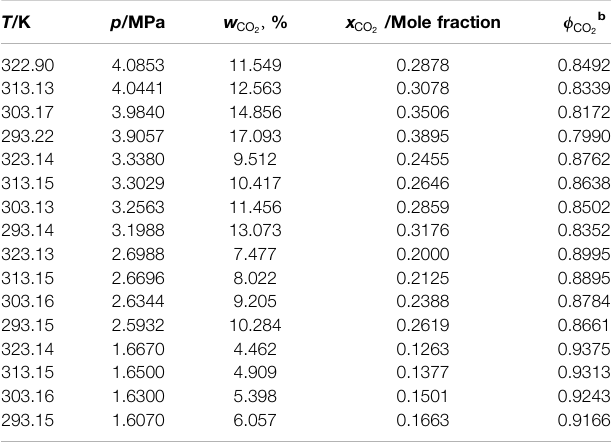
TABLE 4 | Experimental carbon dioxide (CO 2 ) solubility (both in weight percent w CO and in mole fraction x CO 2 system and CO 2 calculated fugacity coef fi cient ( ϕ CO and pressures p. a